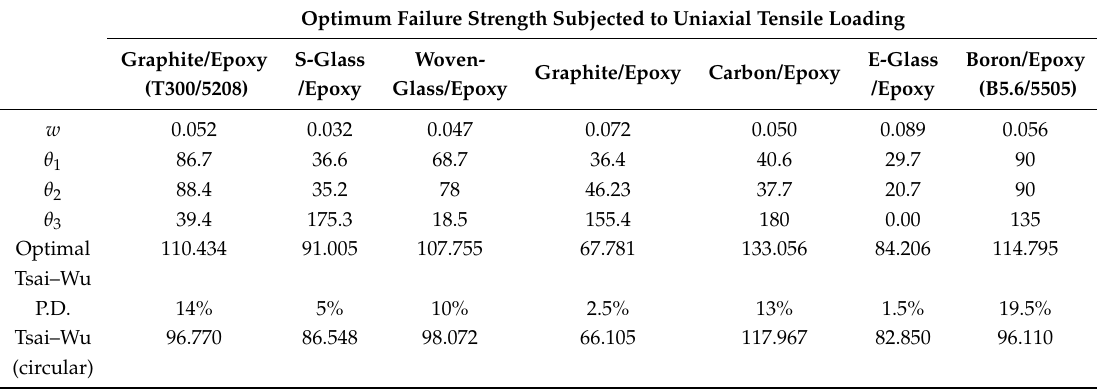
Table 13. Optimal values of the design parameters for different materials ( c = 1) with respect to